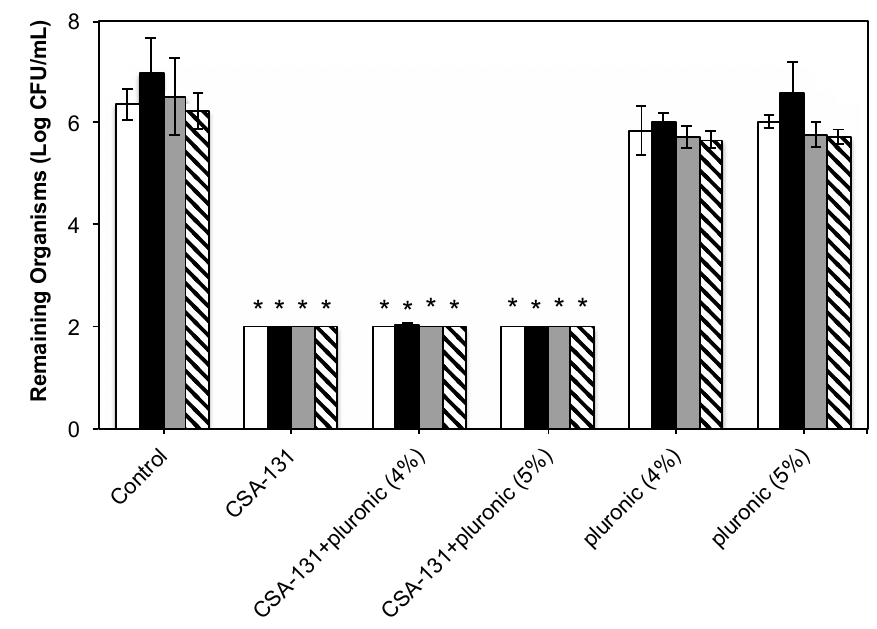
Figure 2. Antibiofilm results determined through the plating of microorganisms freed from biofilms, culturing, and plate counting. White bars: S. aureus (ATCC 25923); black bars: P. aeruginosa (ATCC 47085); gray bars: C. albicans (ATCC 90028); hashed bars: C. auris (CDC 384). Detection limit: 2 logs. * indicates p < 0.05 relative to controls and to pluronic alone.